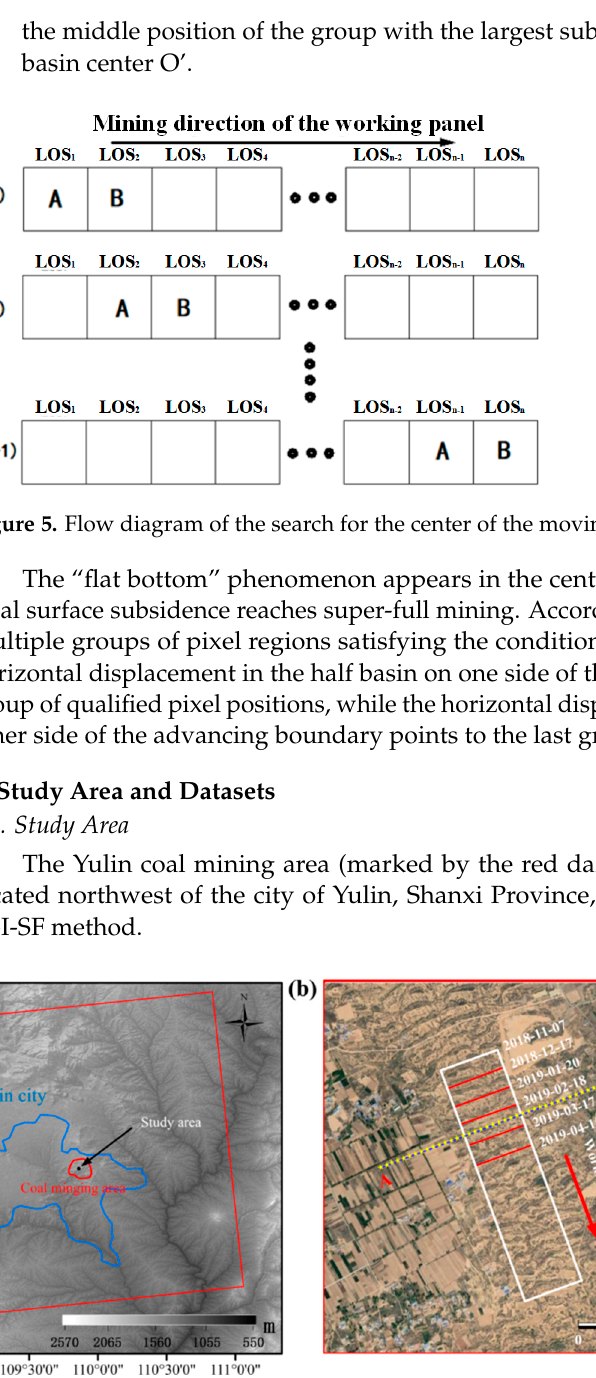
Figure 6. ( a ) Geographic location of the Yulin mining area and the coverage of the SAR acquisitions superposed on the TanDEM. ( b ) Advancing locations of the working panels from 7 November 2018 to 3 December 2019 on the optical image. The white solid rectangles denote the mined working panels. The yellow point is the monitoring point on dip observation line AA’, and the interval between each point is 20 m.